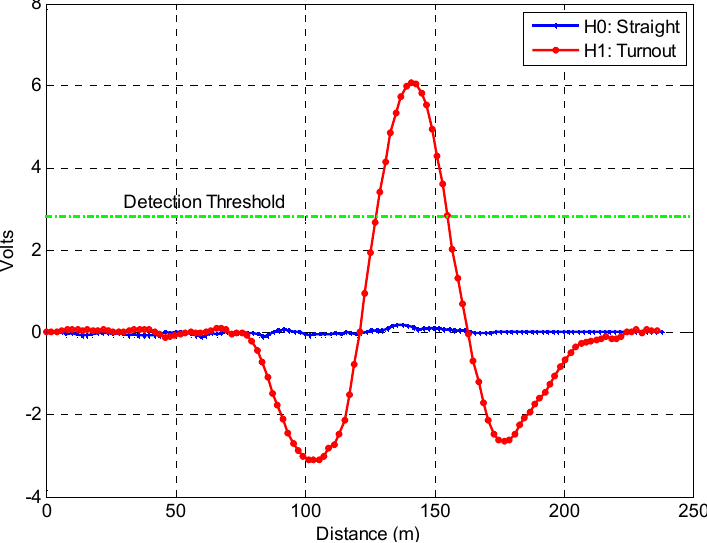
Figure 17. Output of the matched filter in the H0 and H1 trajectories obtained in the Validation 2011 campaign. The horizontal line shows the threshold proposed decision